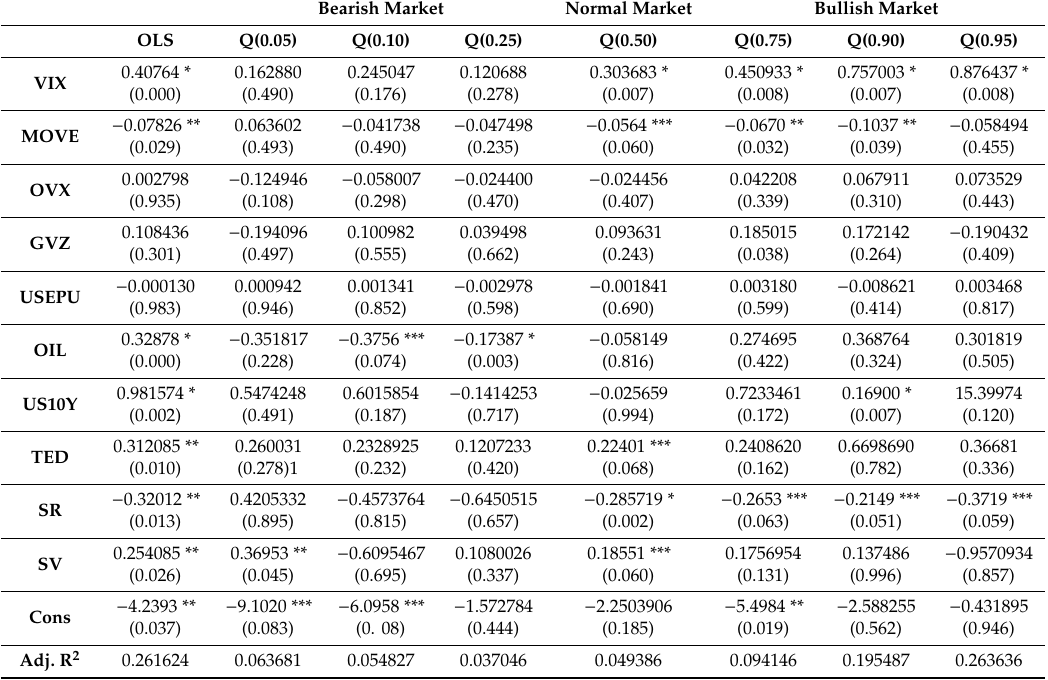
Table 6 and Figure 8 report the quantile estimates in the case of Qatar. Table 6. Quantile regression estimates for